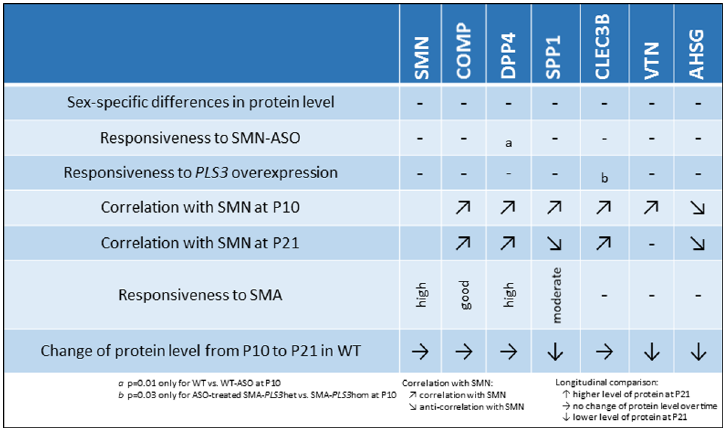
Fig 8. Schematic overview of results for SMN and the six